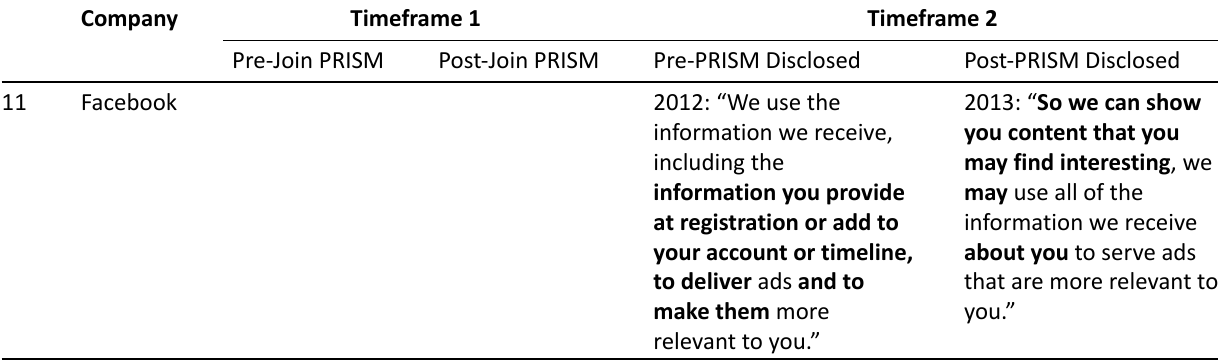
Table A.2. Privacy policy changes related to data sharing and tracking.